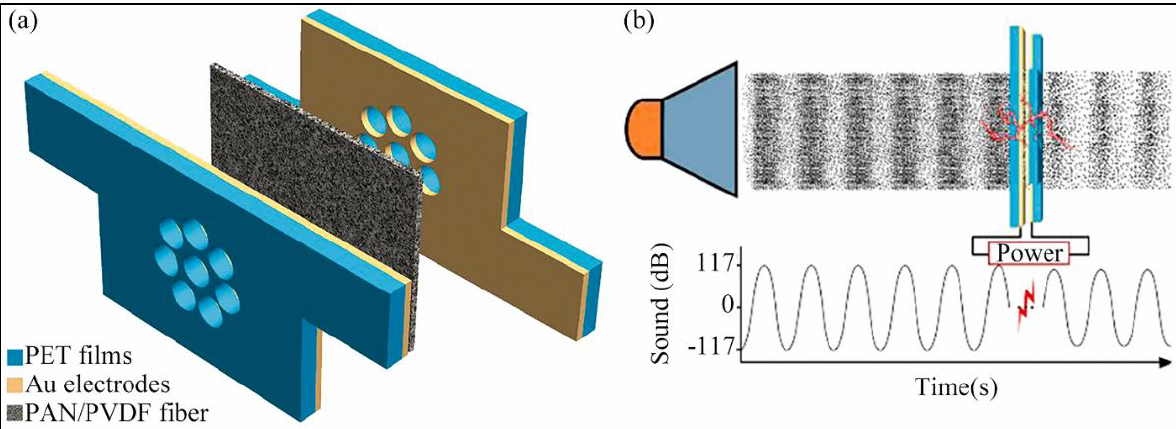
Figure 2. ( a ) Schematic illustration of the PAN/PVDF noise harvester structure; ( b ) Principle of sound energy harvest. Reprinted with permission from ref. [54]. Copyright 2021 Elsevier, Amsterdam, The